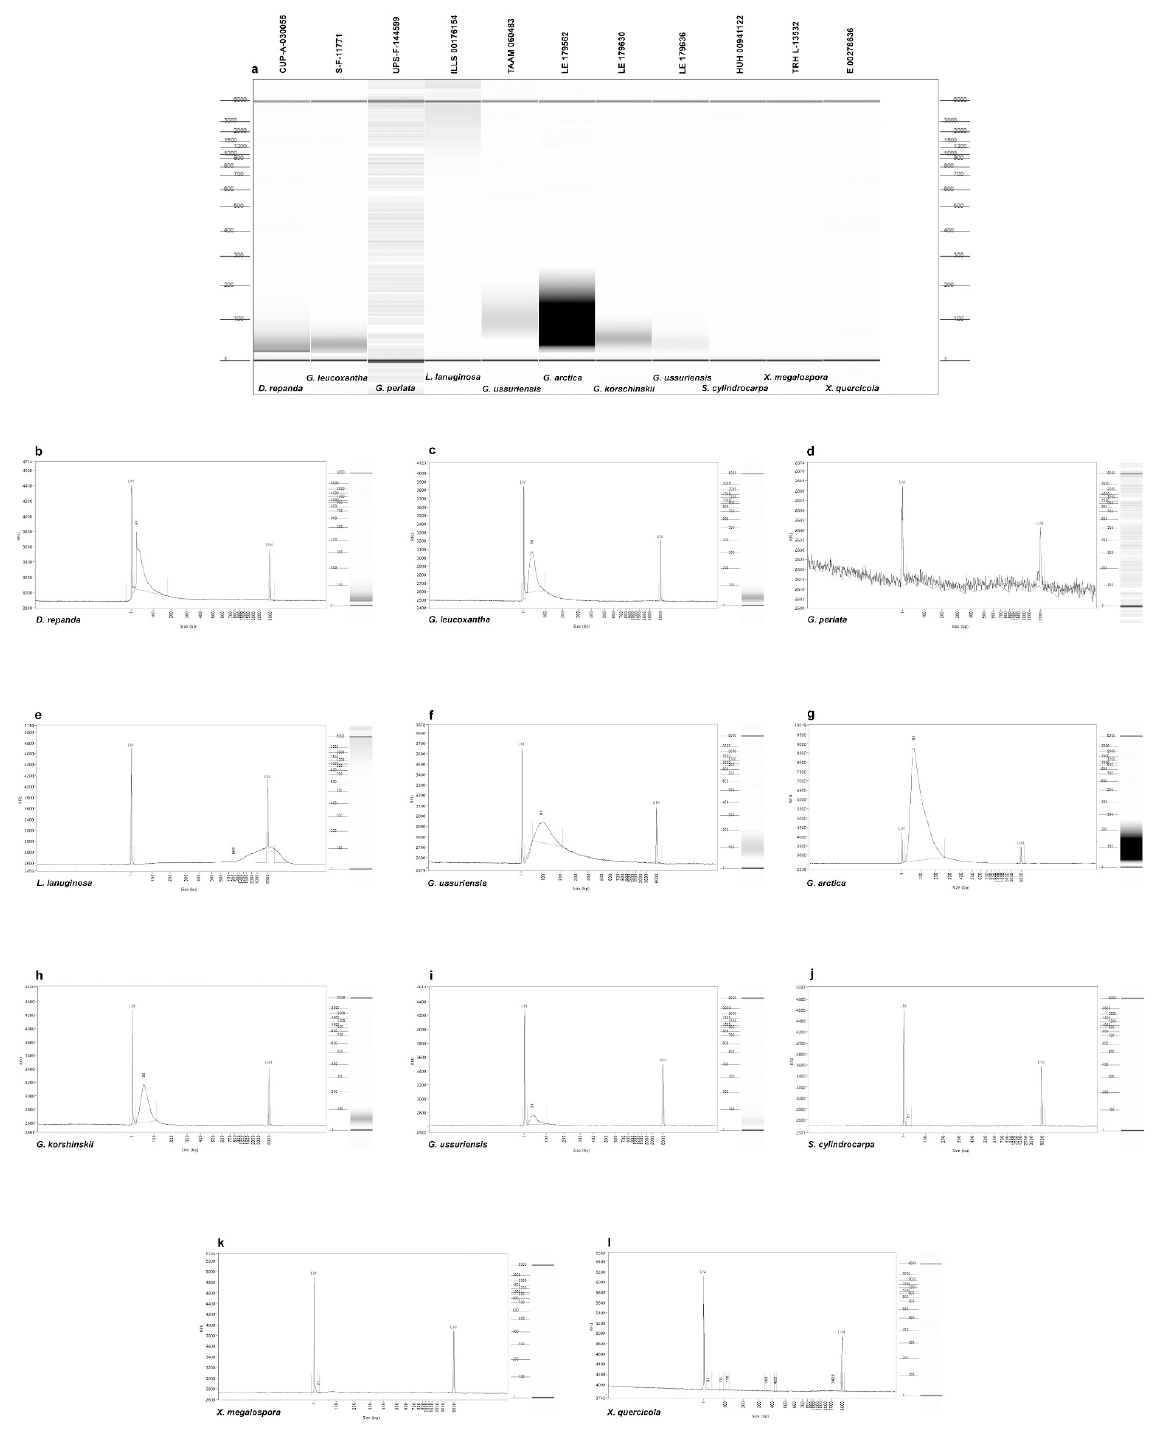
Figure 1. Gel image and graphs showing DNA fragmentation of 11 samples from fragment analyzer. Scales on left and rights sides of gel image indicate base pairs; scale on left side of charts indicates amount of fragmentation in relative fluorescence units; size of fragments is shown in base pairs along bottom; gel image for each sample is repeated to the right of chart with scale in base pairs. ( a ) Gel image showing DNA fragmentation of 11 samples. ( b ) Discina repanda . ( c ) Gyromitra leucoxantha . ( d ) Gyromitra perlata . ( e ) Lasiosphaeria lanuginosa . ( f ) Gyromitra ussuriensis . ( g ) Gyromitra arctica . ( h ) Gyromitra korshinskii . ( i ) Gyromitra ussuriensis . ( j ) Sticta cylindrocarpa . ( k ) Xerotrema megalospora . ( l ) Xerotrema quericola